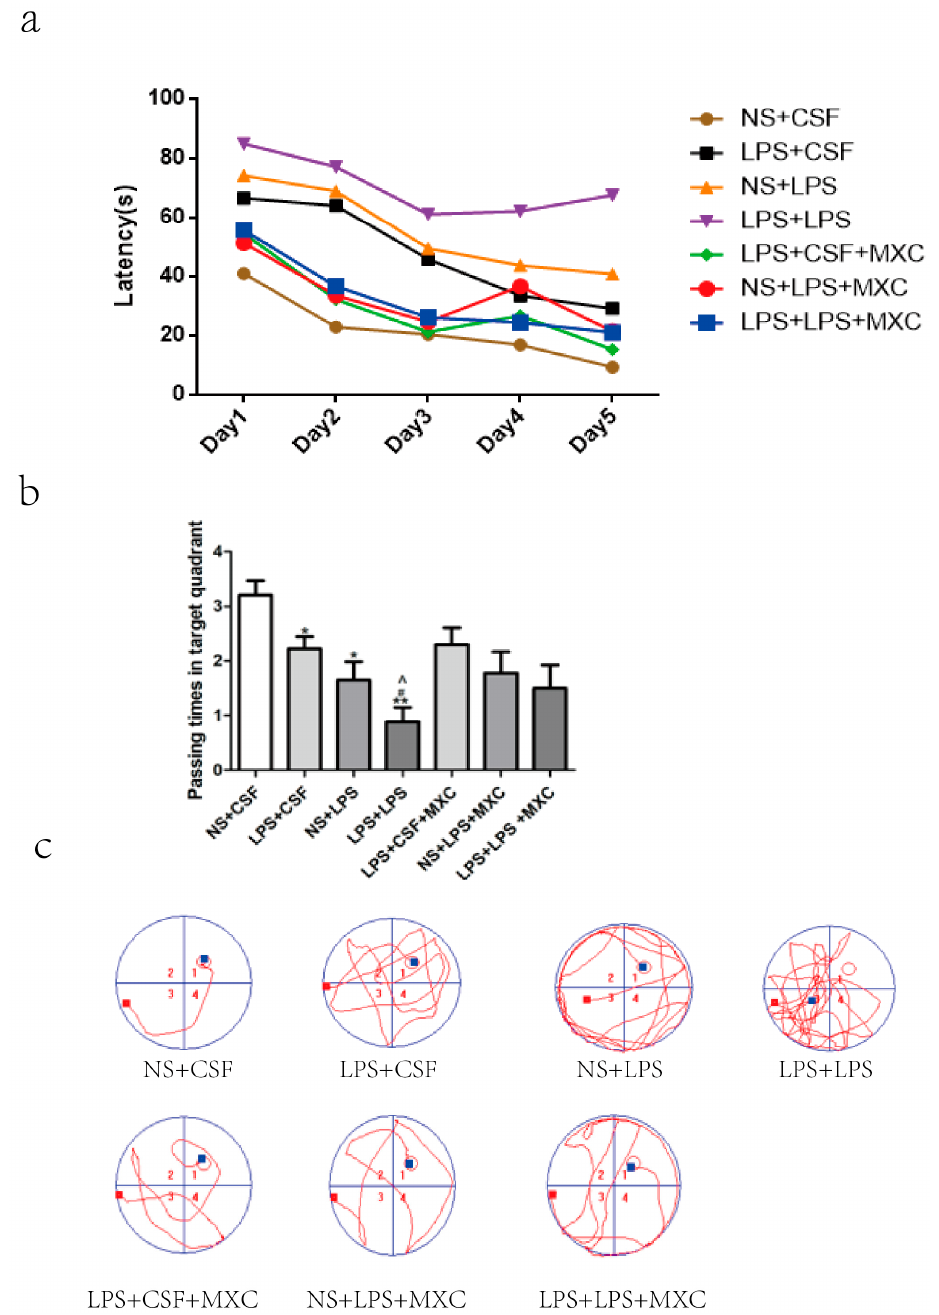
Figure 1. Effect of MXC on learning cognitive function in LPS-treated offspring from prenatal inflammation exposure: ( a ) Comparison of the mean escape latencies to find the hidden platform at days 1–5. Escape latencies were significantly increased in LPS + CSF, NS + LPS, and LPS + LPS groups compared with NS + CSF group. Compared with NS + LPS group, LPS + LPS group animals spent more time in finding. ( b ) Comparison of the mean in the number of crosses in the MWM at day 5. Passing times in target quadrant were significantly decreased in LPS + CSF, NS + LPS, and LPS + LPS groups compared with NS + CSF group. Data are mean ± SEM, n = 9–10. (* p < 0.05, ** p < 0.01 vs. NS + CSF group; # p < 0.05 vs. LPS + CSF group; ^ p < 0.05). ( c ) Comparison of each group to find the trajectory of the hidden platform.